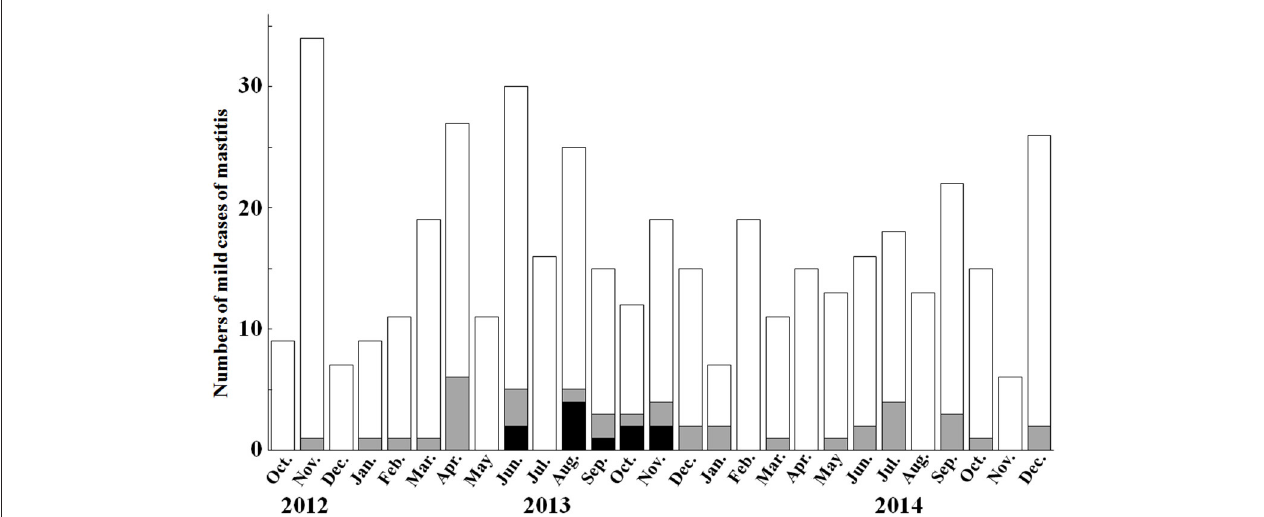
FIGURE 1 | Monthly prevalence of mild mastitis cases and Klebsiella oxytoca -induced mastitis in farm W between October 2012 and December 2014. The monthly prevalence of Klebsiella oxytoca -induced mastitis is recorded as ≥ 20% in April, August, September, October, and November 2013, and January and July 2014. White bars and gray bars show the numbers of mastitic cases, and numbers of Klebsiella oxytoca -induced mastitic cases, respectively. Black bars show the numbers of cases caused by cephalosporin-resistant Klebsiella oxytoca strains.